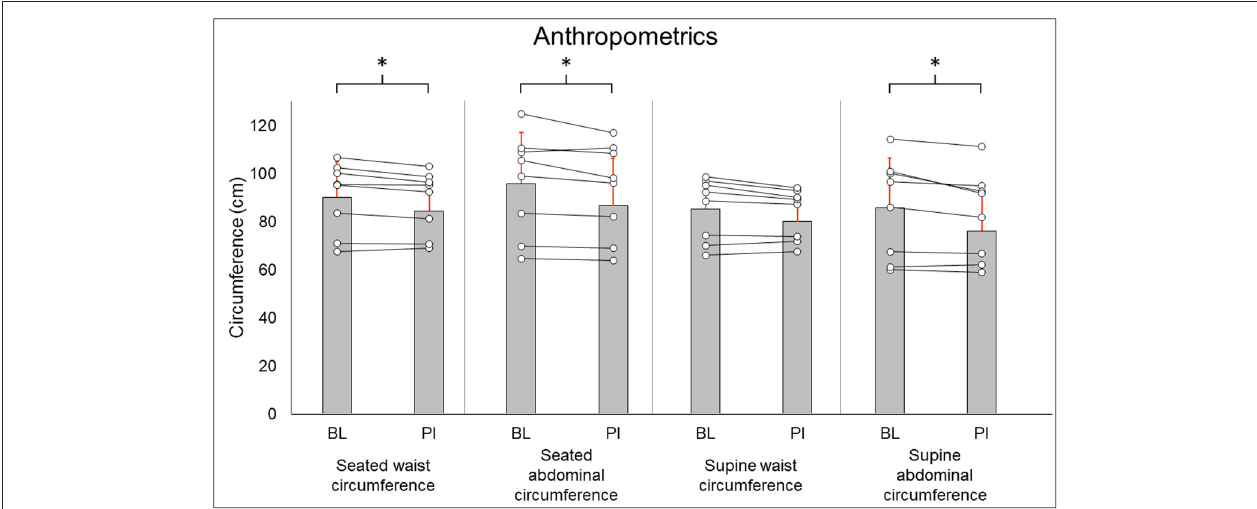
FIGURE 1 | Anthropometric results. Gray bars represent group averages (red lines showing SD), with dots connected by lines representing individual participants and their changes from baseline to post-intervention measurements. BL, baseline; PI, post-intervention. *Significant to P < 0.05.